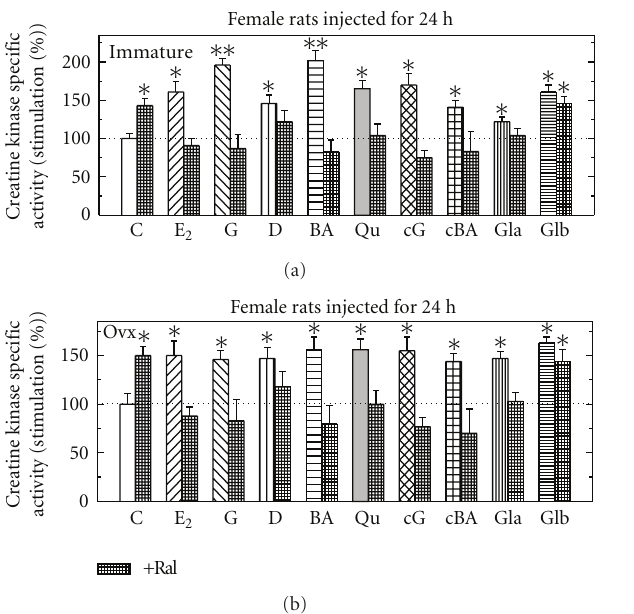
Figure 3: Stimulation of creatine kinase (CK) specific activity by di ff erent estrogenic compounds with and without E 2 in pituitary from immature (a) and from ovariectomized female rats (Ovx; b). Rats were treated and assayed for CK activity as described in Section 2. Results are means ± SEM for n = 5–15 rats/group. Experimental means compared to control means: ∗ P < . 05 and ∗∗ P < . 01. Basal activity in organs from immature and OVX rats were 1 . 02+0 . 15 μ mol/min/mg protein and 0 . 67+0 . 22 μ mol/min/mg protein,